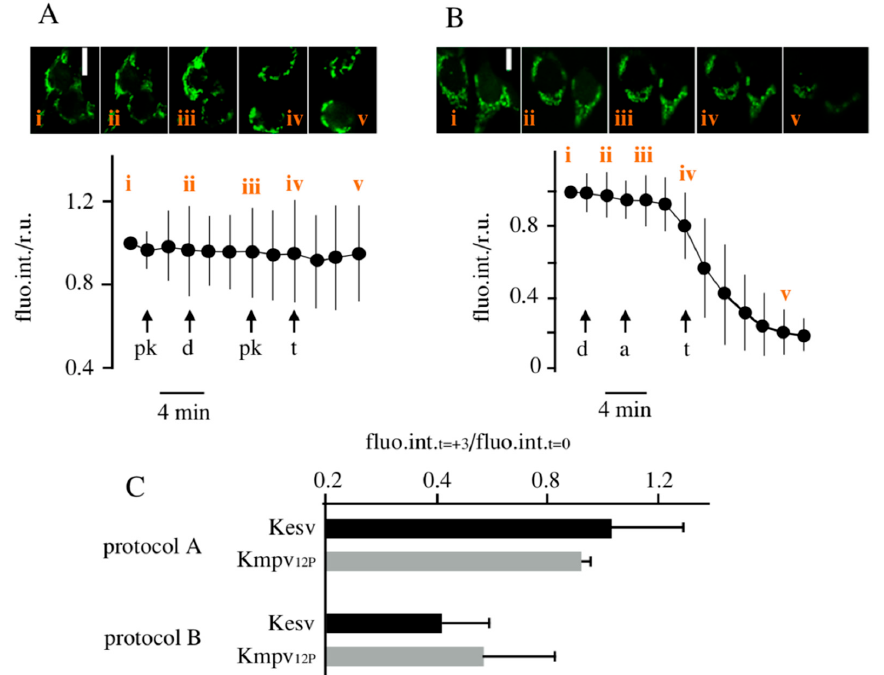
Figure 5. Multistep localization assay confirms the presence of Kesv and Kmpv 12T in inner mitochondria membrane. Cells transfected with [ Kesv/CRY2/CIB1 ] were treated sequentially by adding protein kinase K (pk), digitonin (d), trypan blue (t), and alamethicin (a) at times indicated by arrows in ( A , B ). Before and after treatments, the fluorescent intensity of GFP (fluo.int.) in cells was recorded at defined intervals and normalized to value at the start of the experiment. Data points are the mean ± SD of N ≥ 4 with independent experiments with ≥ 21 cells. ( C ) Ratio of normalized fluorescence intensity from HEK293 cells expressing Kesv or Kmpv 12T measured 3 min after adding trypan blue divided by intensity immediately before treatment (fluo.int t = +3 /fluo.int t = 0 ). Data are the means ± SD of N = 5 independent experiments with n > 39 cells using either protocol from A (protocol A) or B (protocol B). Scale bars: 10 μ m.